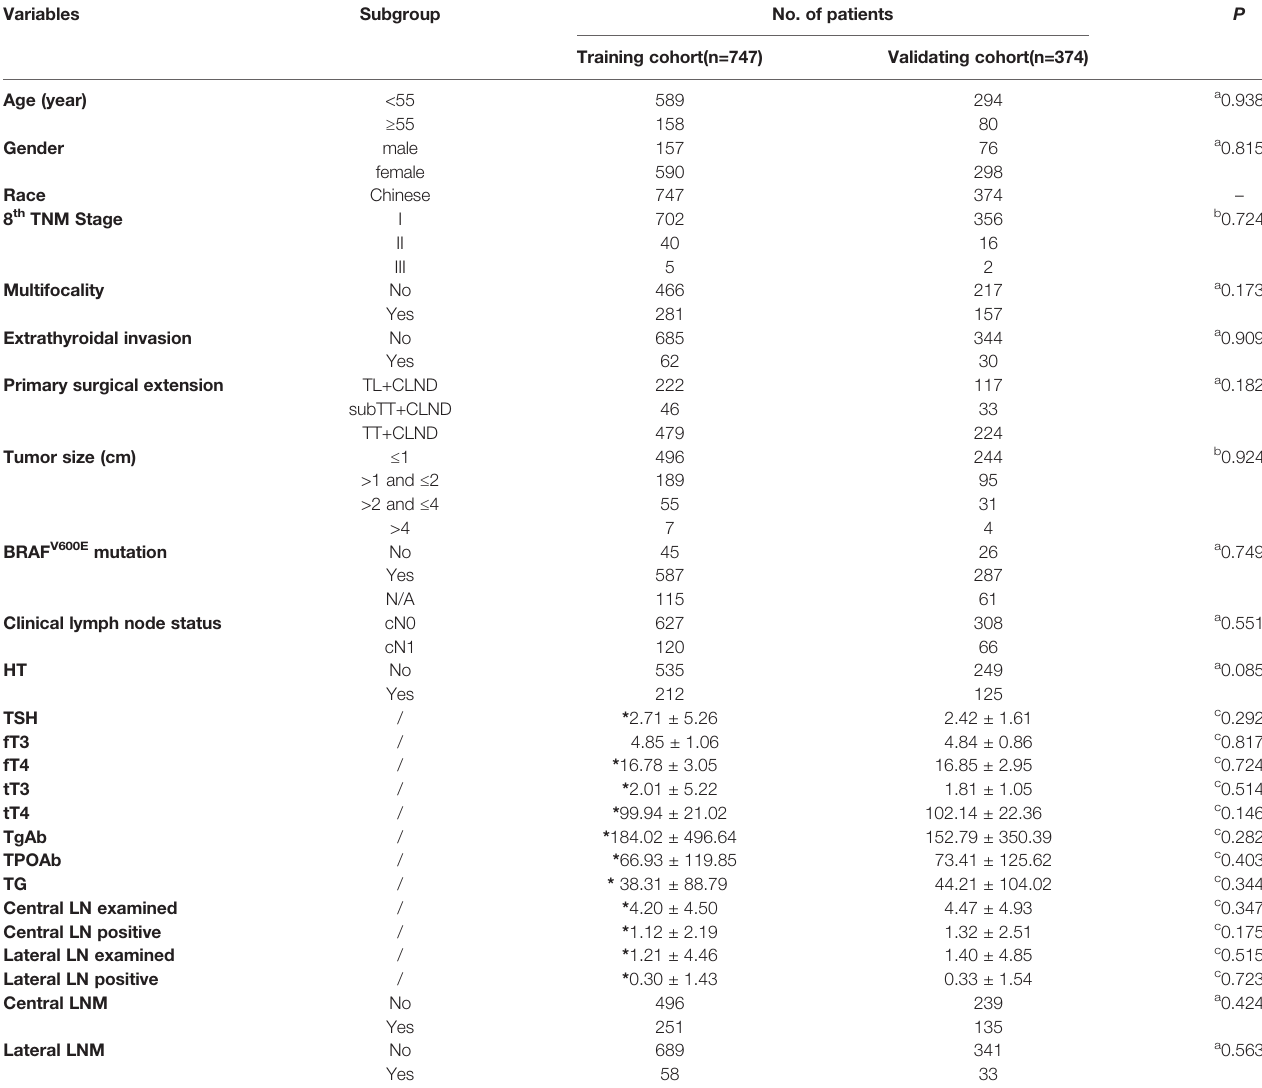
TABLE 1 | The clinicopathological characteristics of classical PTC patients. Variables